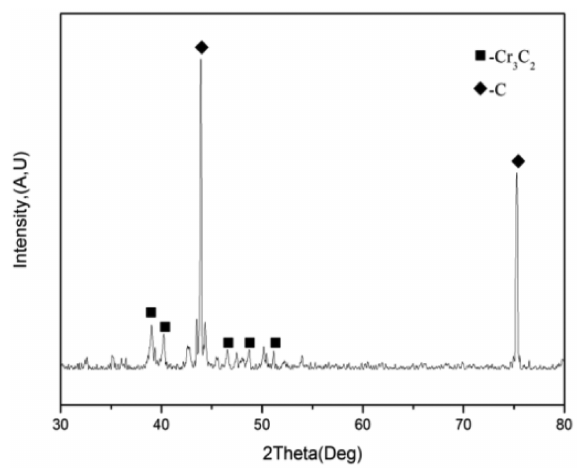
Figure 6: X-ray diffraction pattern of coated diamond by microwave heating at the temperature of 850 ° C for 1h.